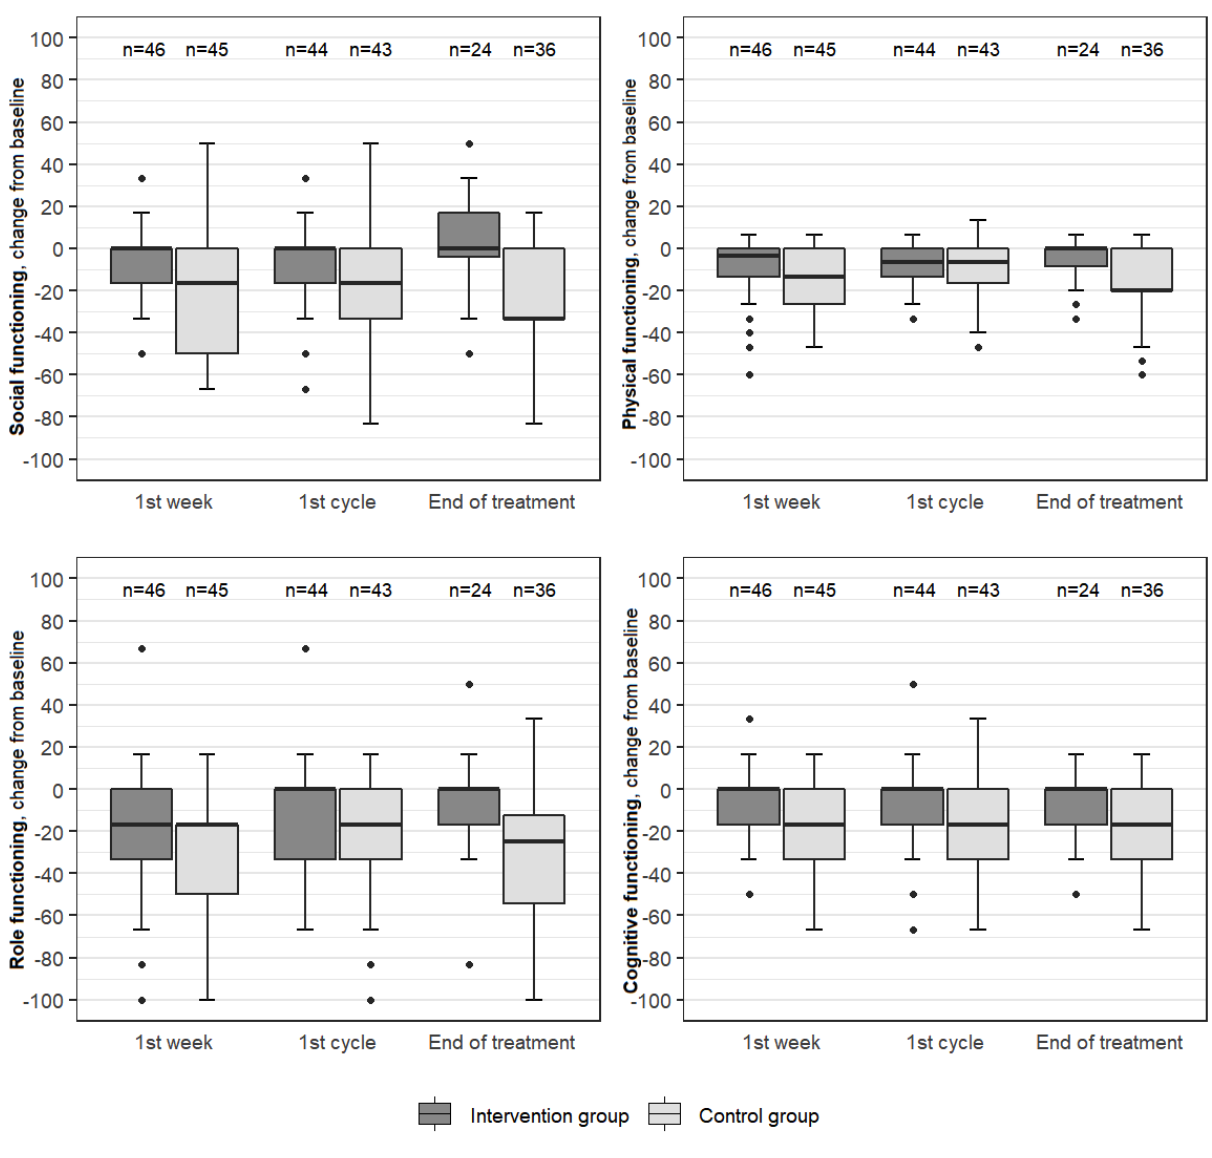
Figure 3. Boxplots showing change from baseline for the selected functional scales of the EORTC QLQ C-30 and BR-23. EORTC: European Organisation for Research and Treatment of Cancer; QLQ BR-23: Quality of Life Questionnaire Breast Cancer Module; QLQ C-30: Quality of Life Questionnaire Core